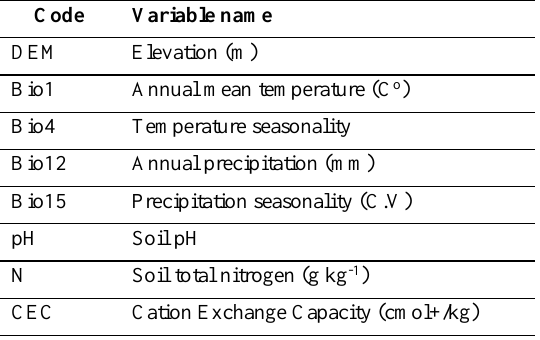
Table 1. Input biophysical grid layers